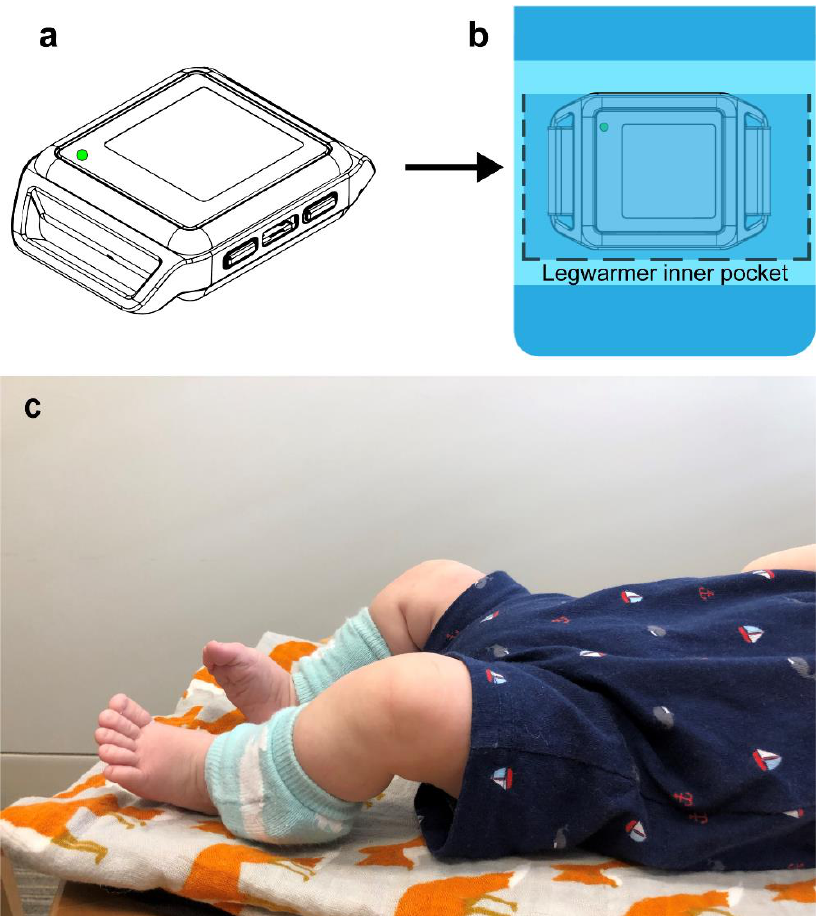
Figure 1. ( a ) Illustration of a wearable sensor; ( b ) Illustration of how the wearable sensor is positioned within a legwarmer; ( c ) Infant wearing sensors and legwarmers on both ankles. Table 1. Infant Characteristics.